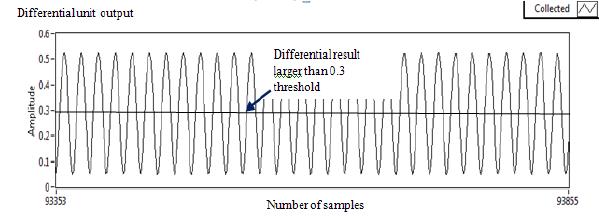
Figure 12. Differential unit output with instantaneous samples ’ calculation